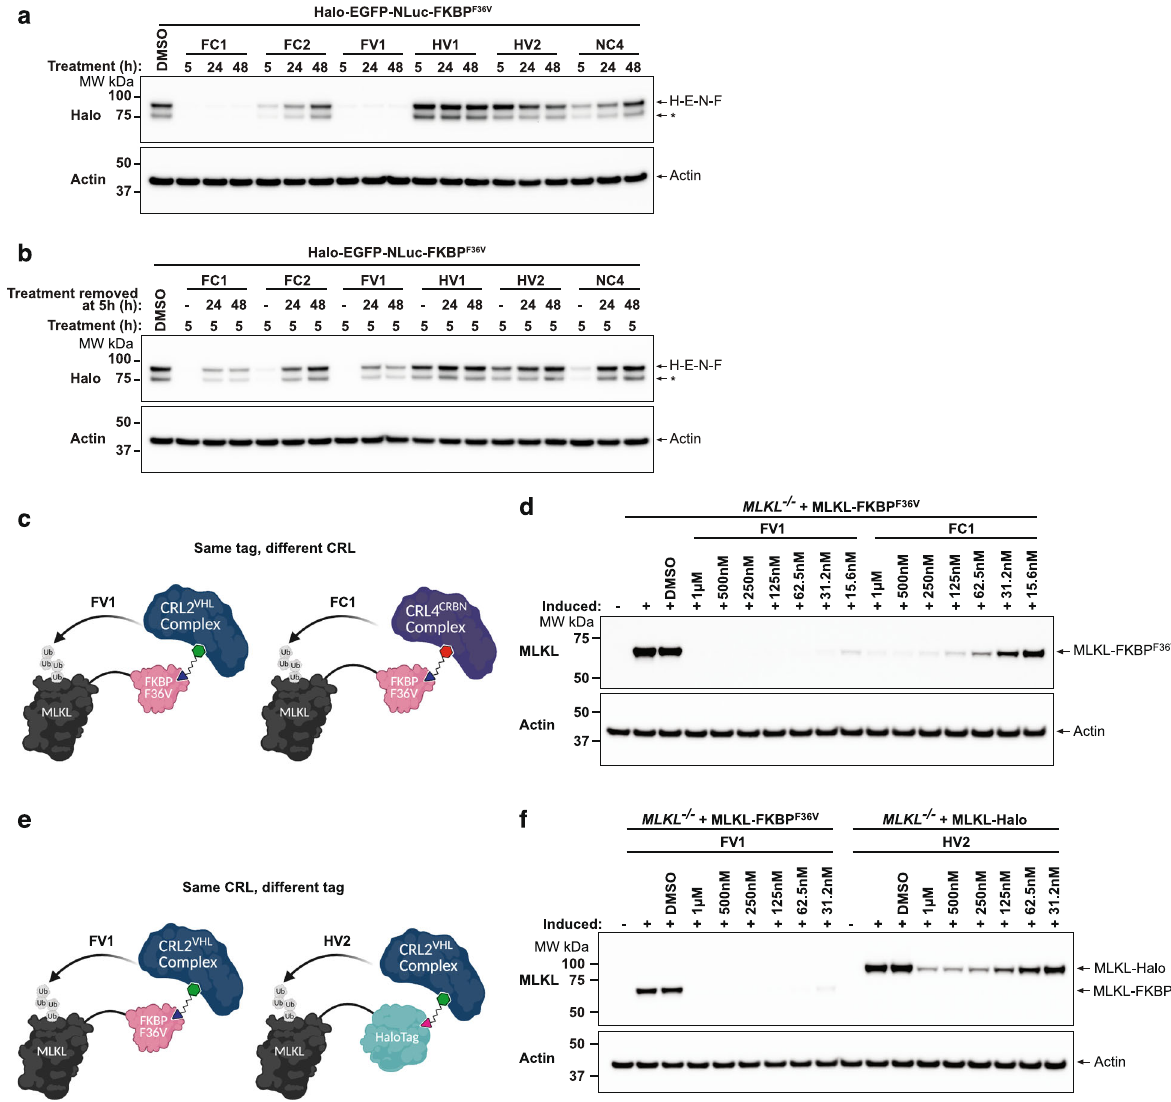
Fig. 4 F36V-VHL degrader outperforms CRBN and Halo targeting degraders. a Western blot analysis of total cell lysates from immortalized MDFs (iMDFs) constitutively expressing H-E-N-F. Cells were stimulated with DMSO or stimulated with 500 nM of FC1, FC2, FV1, HV1, HV2 or NC4 degrader compounds for 5, 24 or 48 h. Asterisk (*) indicates possible cleavage product. b Western blot analysis of total cell lysates from immortalized MDFs (iMDFs) constitutively expressing H-E-N-F. Cells were stimulated with DMSO or stimulated with 500 nM of FC1, FC2, FV1, HV1, HV2 or NC4 degrader compounds for the fi rst 5 h. Degraders were then removed from the culture medium at 5 h and cells were incubated for 24 or 48 h. Minus sign ( − ) indicates that sample was harvested at the time the treatment was removed (5 h). Asterisk (*) indicates possible cleavage product. c Schematic depicting the comparison of selected tTPD systems; F36V-VHL (FV1) and F36V-CRBN (FC1). d Western blot analysis of total cell lysates from MLKL − / − HT29 cells stably expressing the doxycycline-inducible C-terminal fusion protein MLKL-FKBP F36V . Cells were treated with 40 ng/mL doxycycline overnight to induce the constructs, then stimulated with the indicated concentrations of FV1 (F36V-VHL) or FC1 (F36V-CRBN) for 5 h. e Schematic depicting the comparison of selected tTPD systems; F36V-VHL (FV1) and Halo-VHL (HV2). f Western blot analysis of total cell lysates from MLKL − / − HT29 cells stably expressing the doxycycline-inducible C-terminal fusion protein MLKL-FKBP F36V or MLKL-Halo treated with 40 ng/mL doxycycline overnight to induce the construct, then stimulated with the indicated concentrations of FV1 (F36V-VHL) or HV2 (Halo-VHL). All experiments were repeated independently three times, and